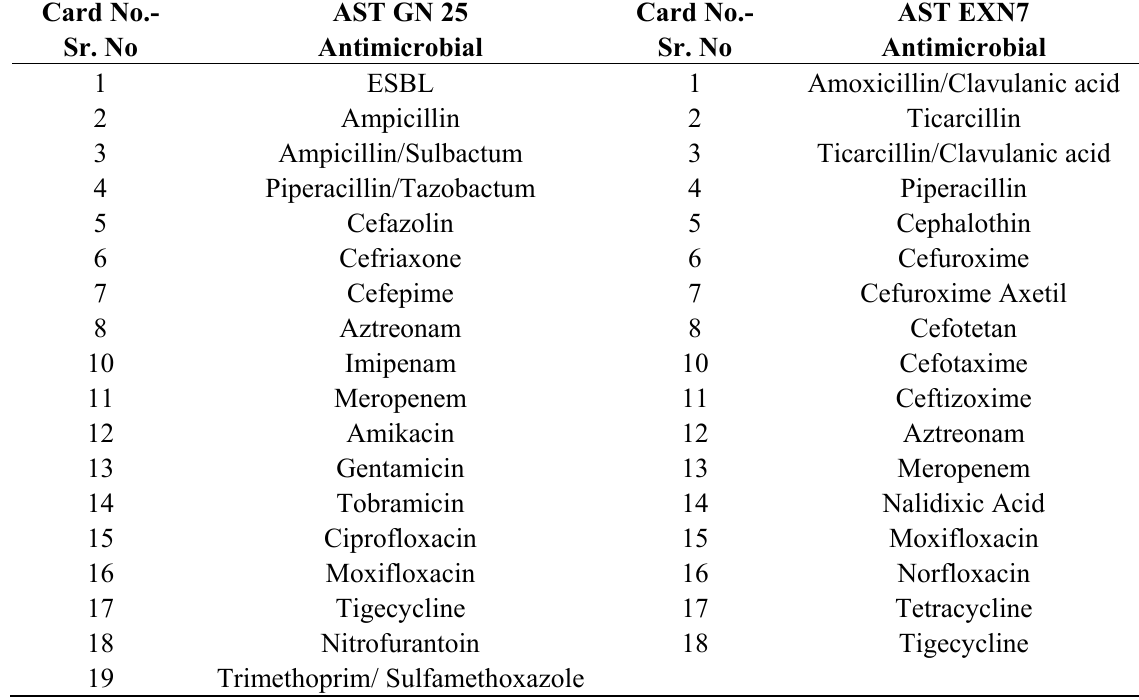
Table A1. List of antibiotics used for susceptibility testing using the Vitek 2 AST (antibiotic susceptibility test)